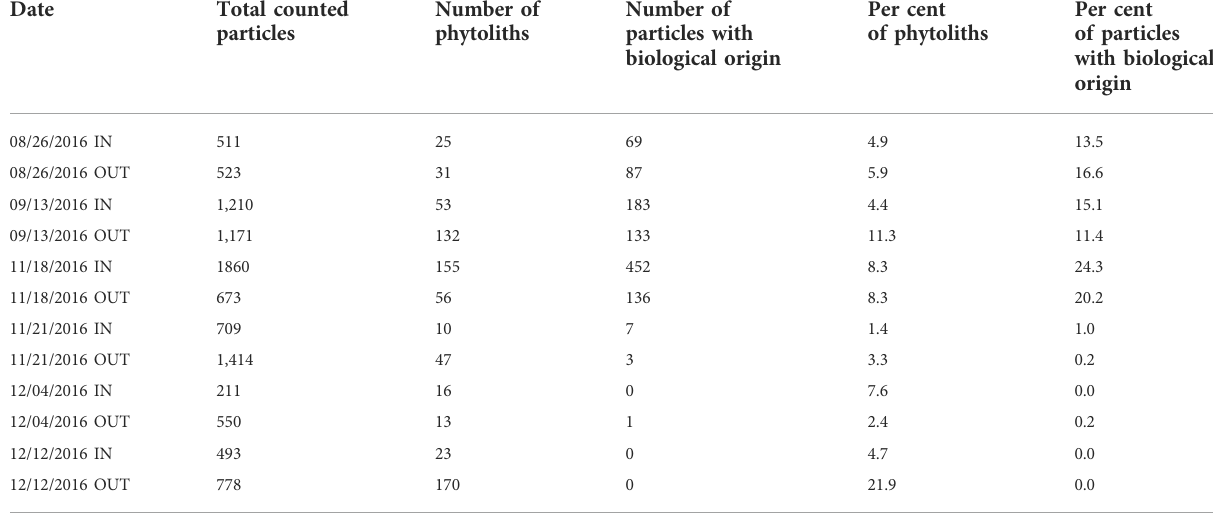
TABLE 2 Results of the visual analyses of fi lter loadings by particle